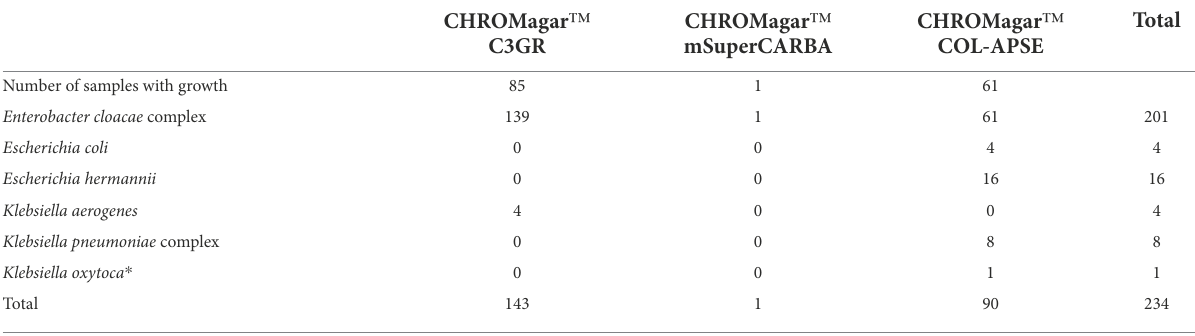
TABLE 1 Number of feed-mill samples with growth of investigated bacteria genera and identified bacterial species from the three agar plates.